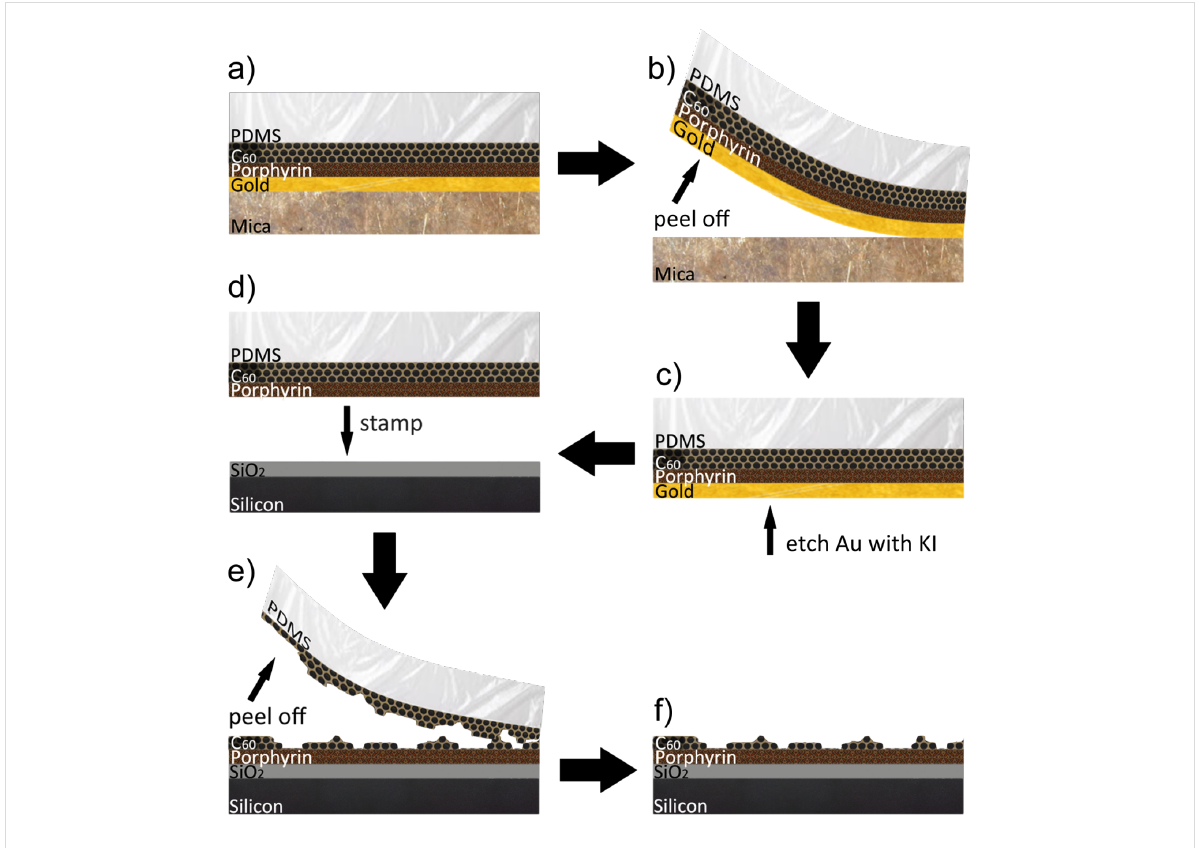
Figure 1: Schematic process for the transfer of porphyrin using C 60 as an adhesive and protection layer.